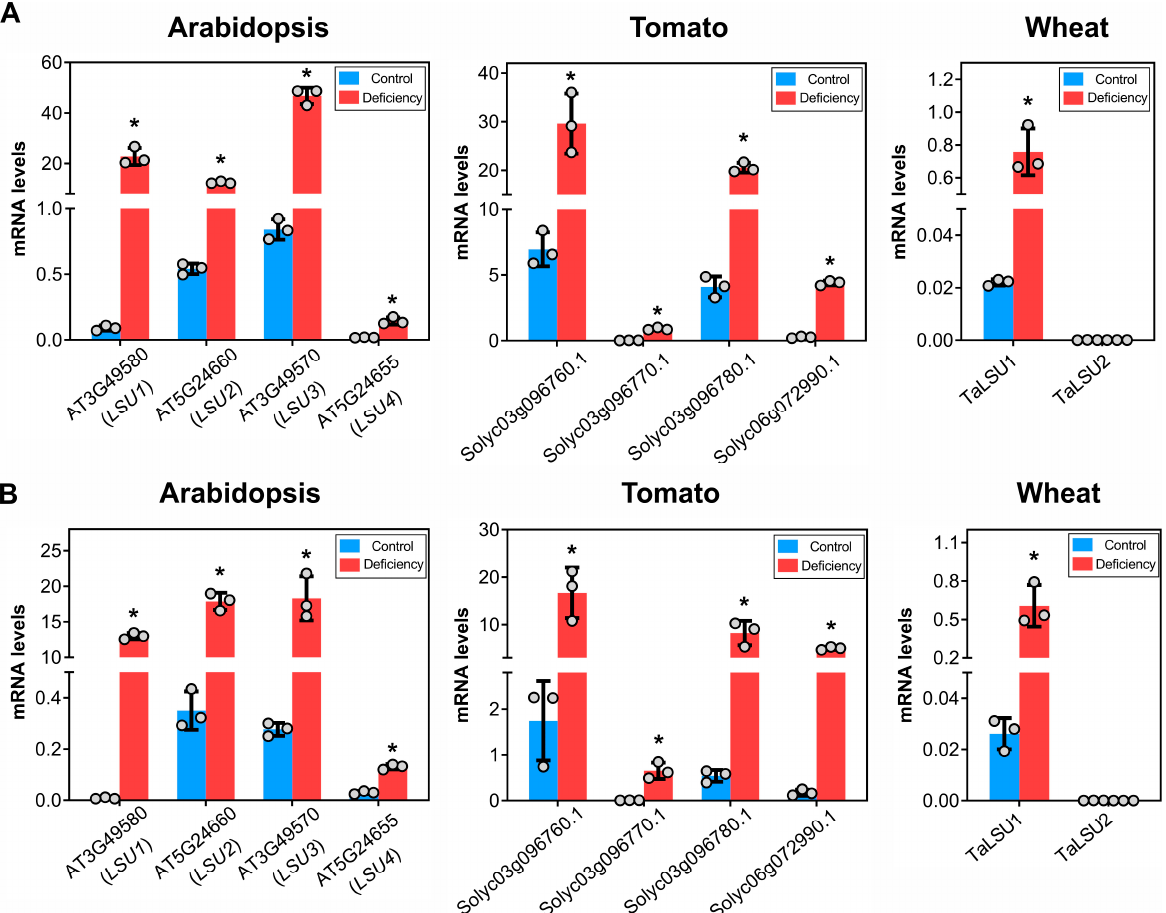
Figure 5. Expression profiles of LSU genes of wheat, Arabidopsis and tomato under S deficiency. The mRNA levels of the LSU gene family were measured by RT-qPCR in leaves ( A ) and roots ( B ) of each species grown for 3 weeks in a liquid medium under control and S-deficiency conditions. The expression levels were normalized with the ADAPTOR PROTEIN-4-MU-ADAPTIN gene (AT4G24550) in the case of Arabidopsis [46], TIP4I-like family protein (TIP4I, SGN-U584254) for tomato [47] and the Ubiquitin-conjugating enzyme gene (TraesCS4A02G414200) for wheat [48]. Each treatment was performed using three independent experiments. The bars represent the arithmetic mean, and the asterisks indicate the mean of the measurements that are significantly different according to a Student’s t- test with p < 0.05.